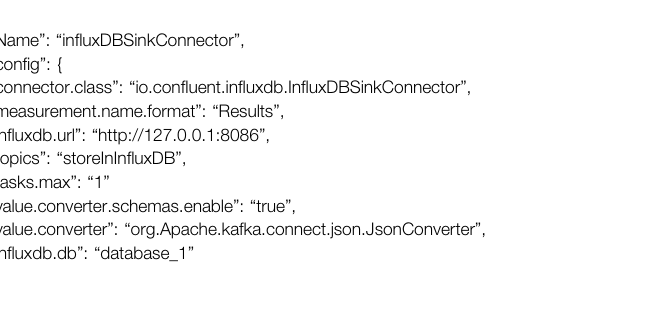
TABLE 4 | Con fi guration of a Kafka Sink Connector for a local In fl